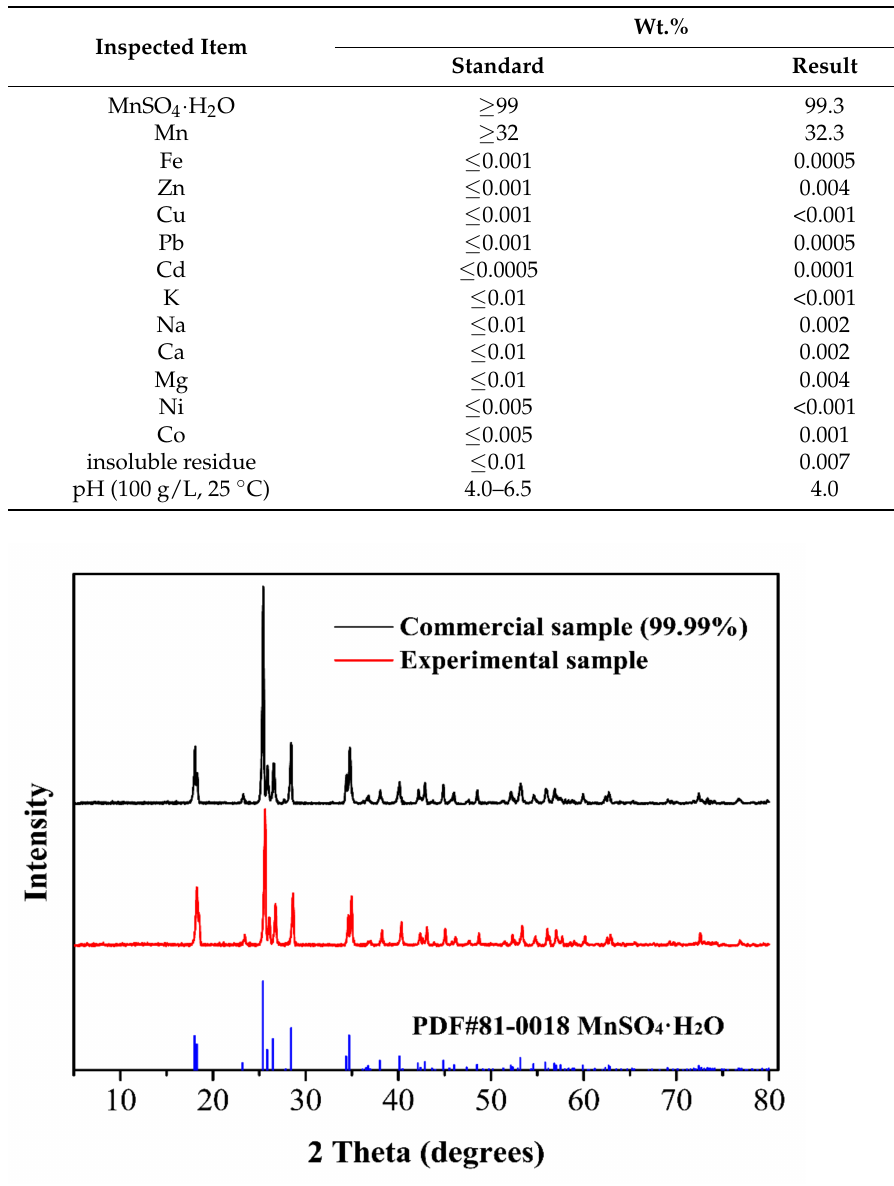
Table 3. Test standards and ICP/AAS results of high-purity MnSO 4 • H 2 O crystals.